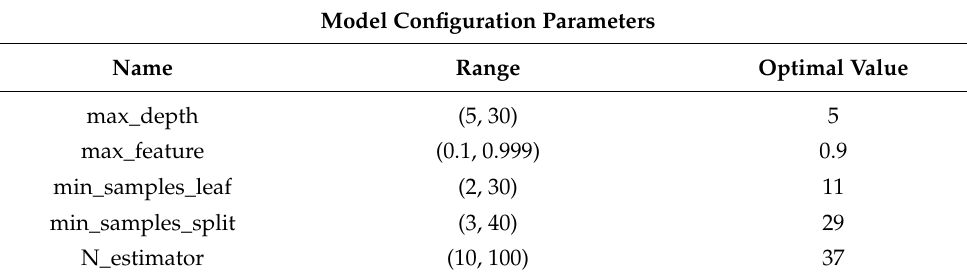
Table 3. Optimal hyperparameters and range of hyperparameters for multi-output